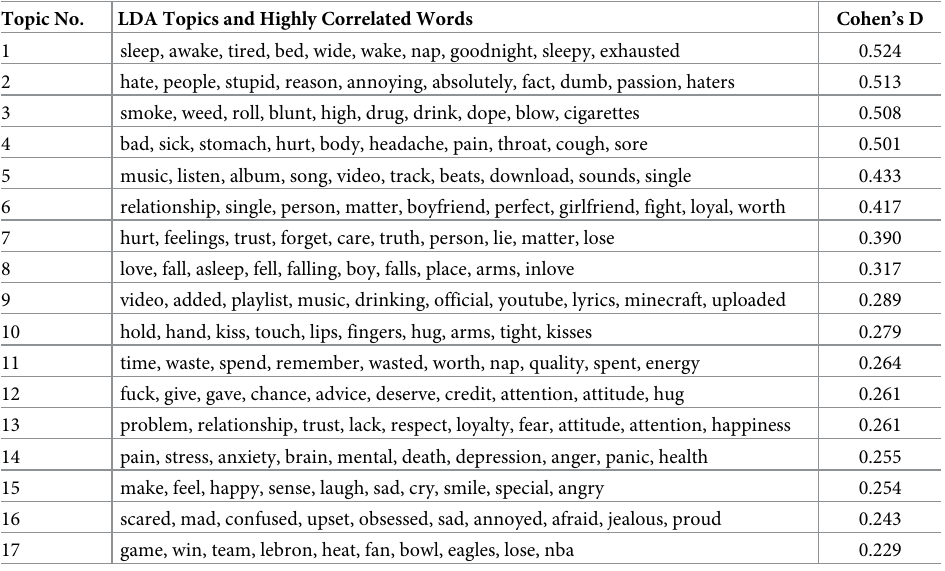
Table 9. Results from LDA analysis for female: 18—22. Topic No.